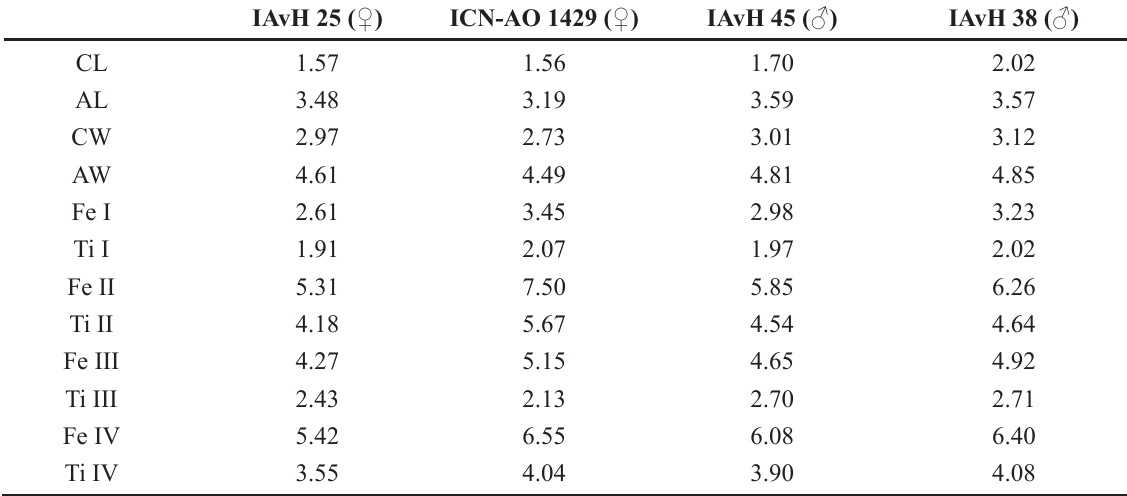
Table 1. Measurements of body and appendages of Eulibitia helena sp.